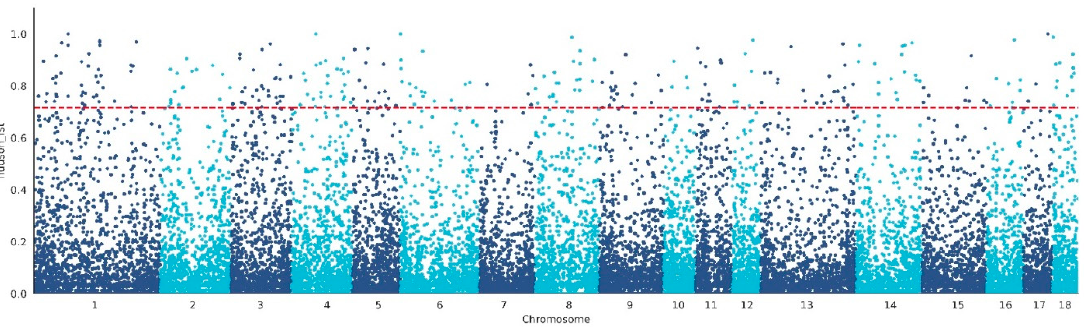
Figure 3. Identification of the selected CNVs in WBP with Fst. The red line represents the top 1% threshold.